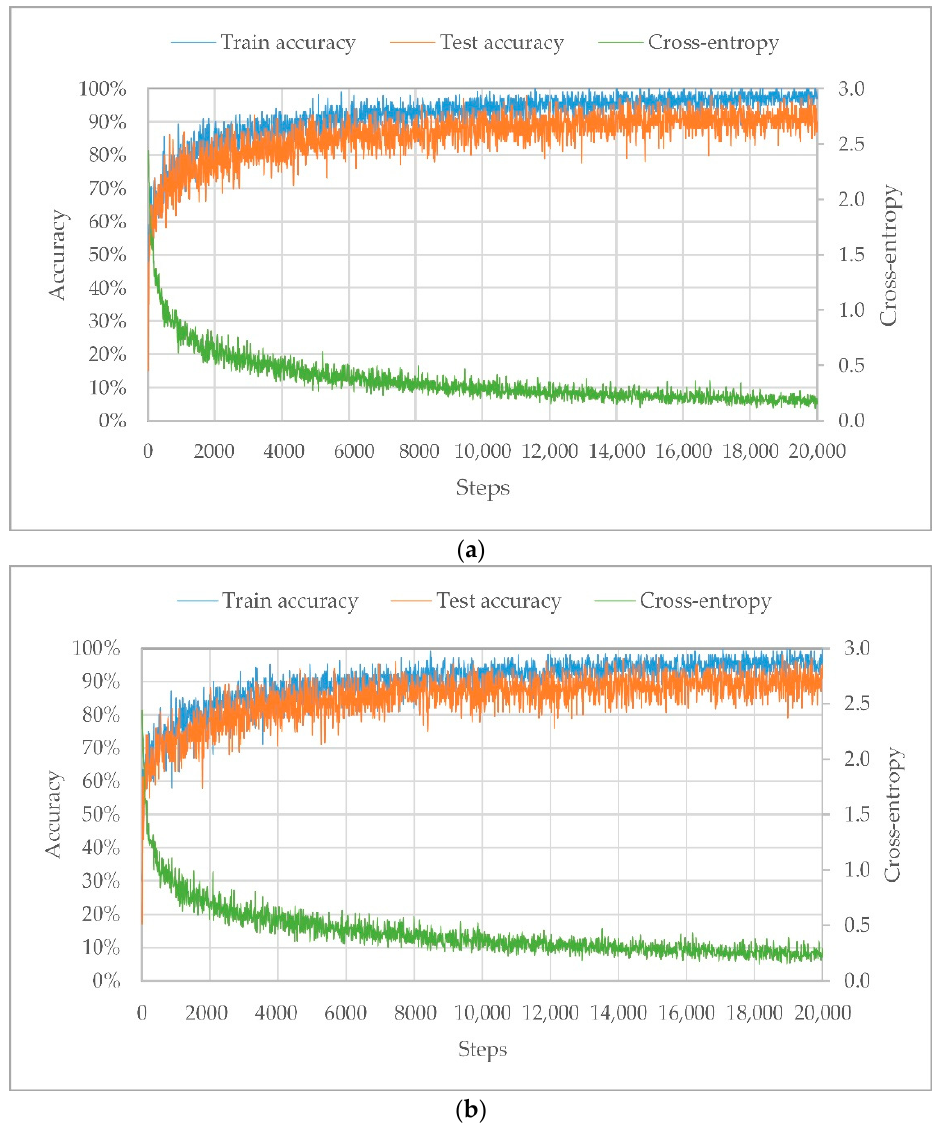
Figure 6. Train accuracy, validation accuracy and cross-entropy variation in transfer learning process: ( a ) Grayscale dataset; ( b ) Color dataset.